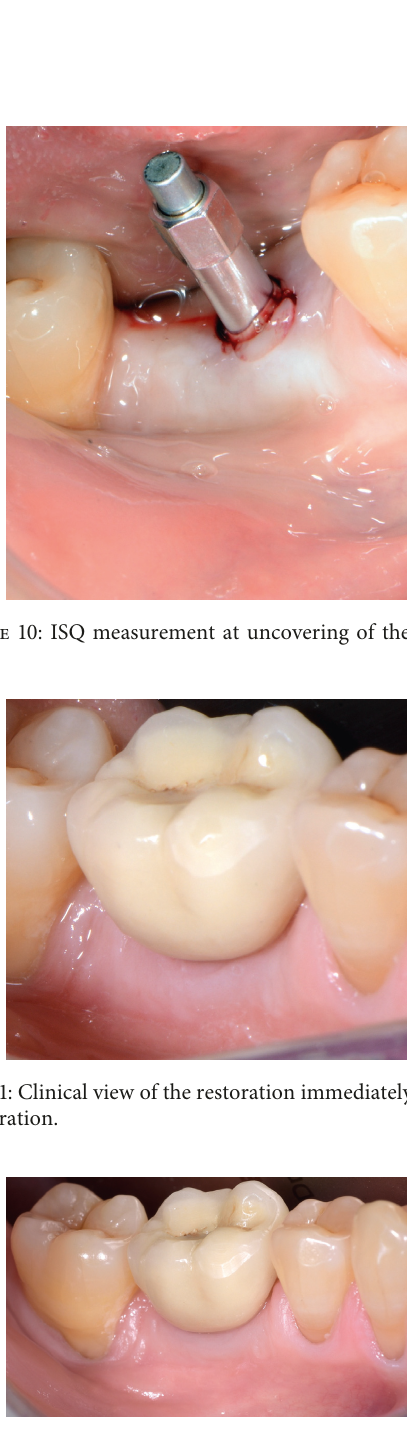
Figure 12: Clinical view two years after loading the